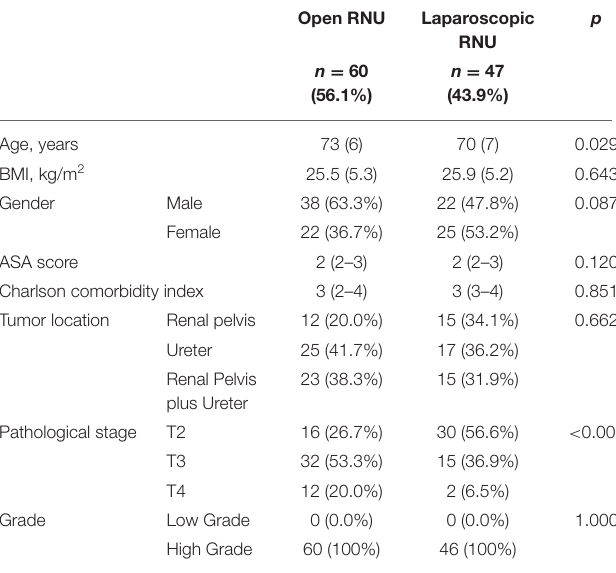
TABLE 2 | Comparison of urothelial carcinoma recurrence incidence and Site according to surgical approach. Type of approach Open